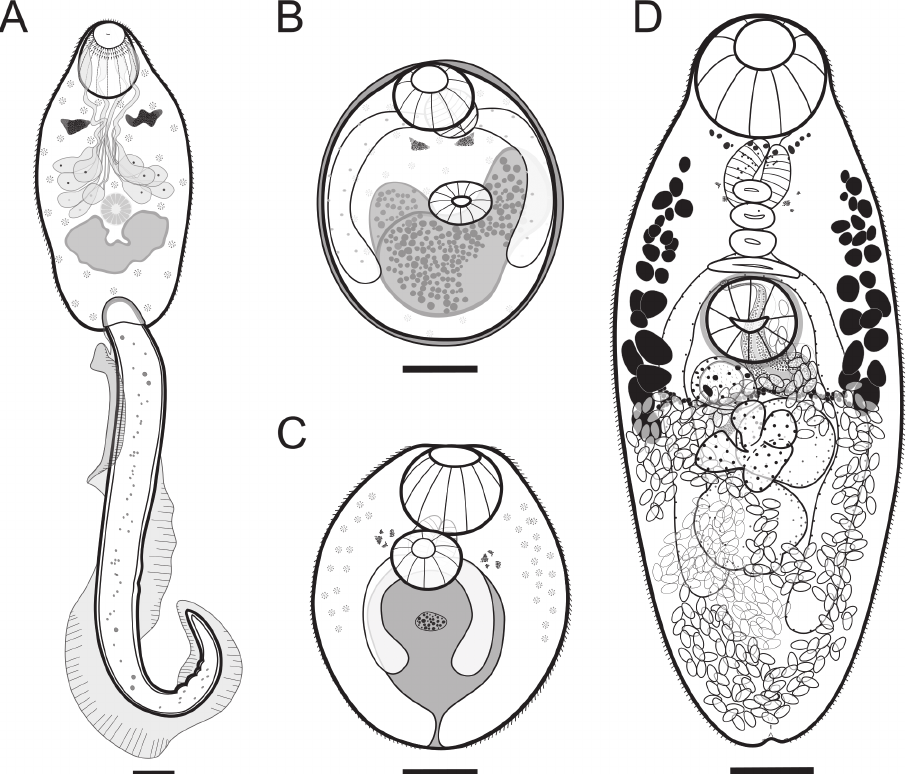
Figure 3. Developmental stages of Oligogonotylus andinus sp. nov. A pleurolophocercous cercaria emerged from Aroapyrgus colombiensis B encysted metacercaria isolated from the muscle of Poecilia caucana C unencysted metacercaria isolated from P. caucana D holotype, adult isolated from the large intestine of the trans-Andean cichlid Andinoacara latifrons . Scale bars: 20 µm ( A ); 20 µm ( B, C ); 100 µm ( D